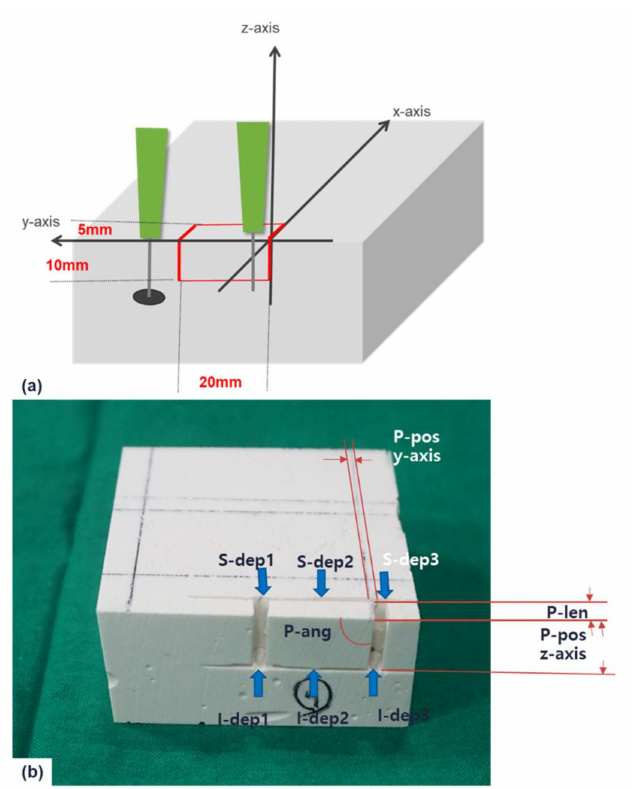
Figure 3. Design of model ramal bone graft osteotomy ( a ), measurements of model ramal bone graft osteotomy. P-pos: posterior position error, P-len: posterior length error, P-ang: posterior angle error, I-dep: inferior depth error, S-dep: superior depth error ( b